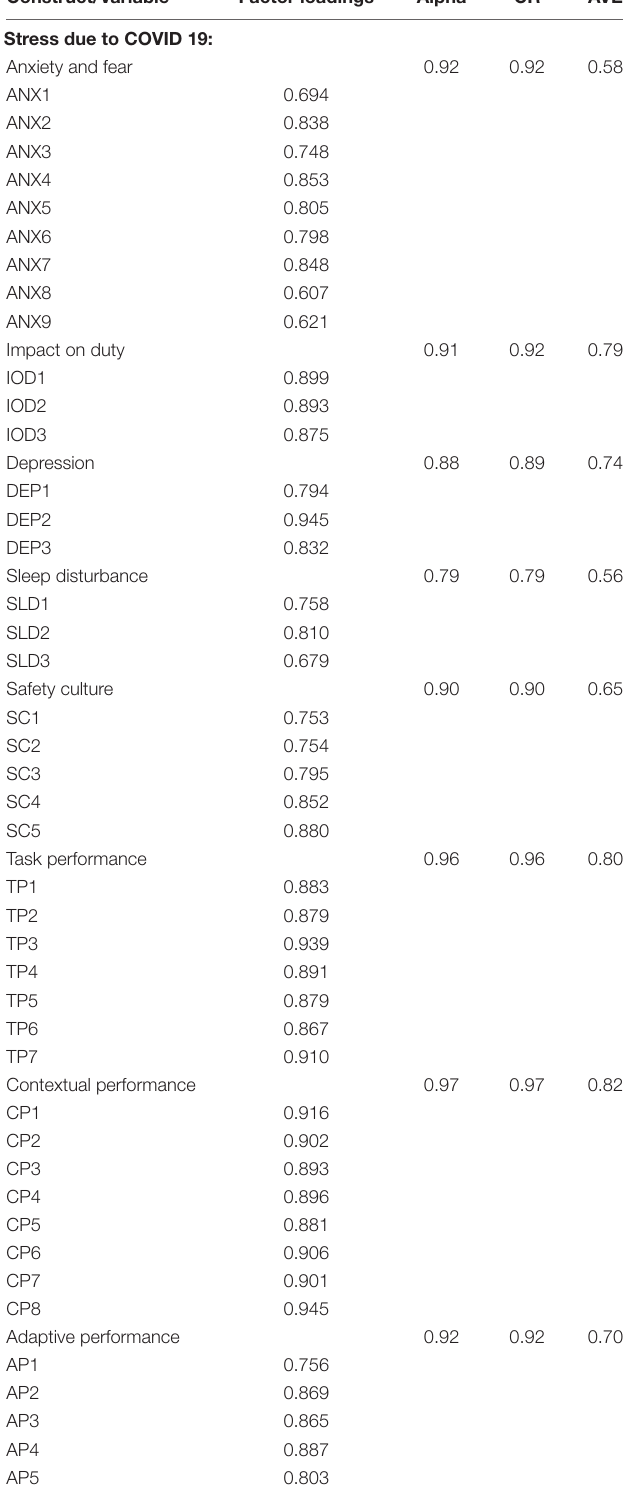
TABLE 2 | Results of confirmatory factor analysis